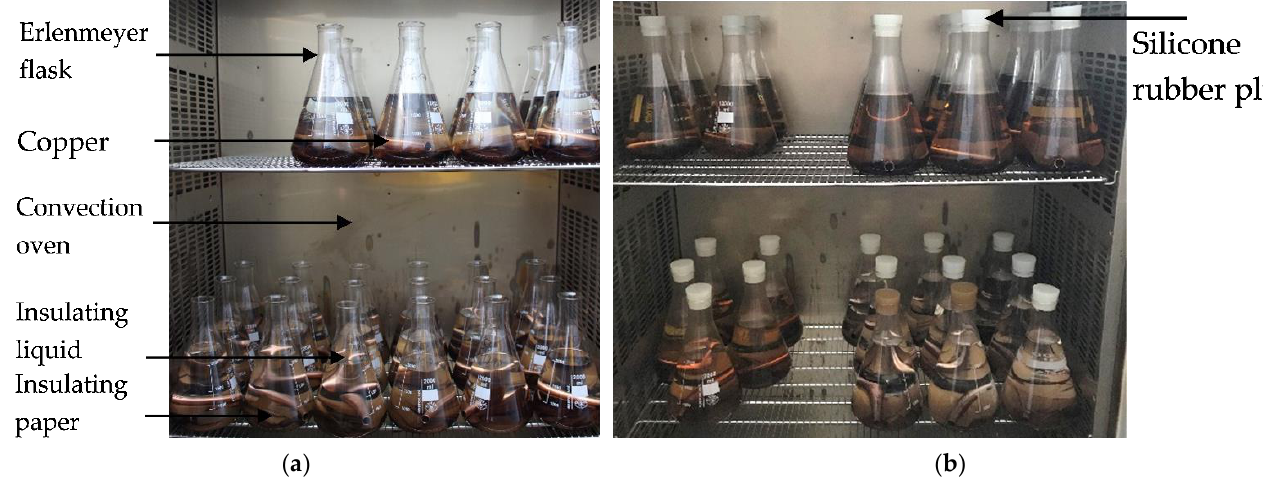
Figure 3. Thermally accelerated aging process of oil-paper insulation in a convection oven with Erlenmeyer flasks: ( a ) Open system; ( b ) Closed system.